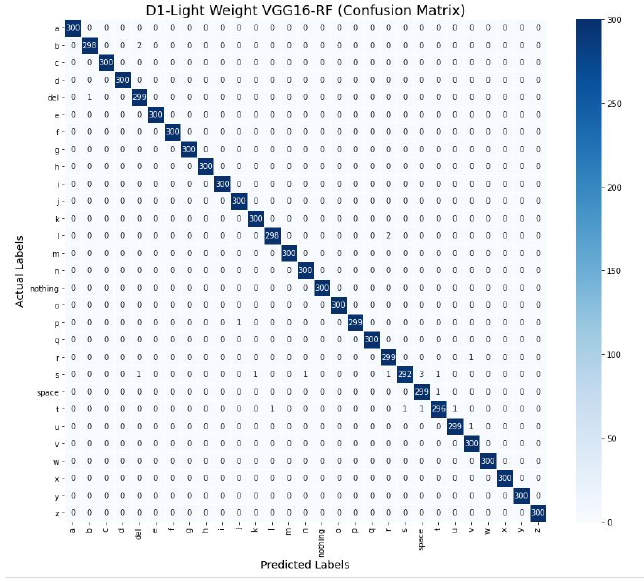
Figure 9. The confusion matrix of the lightweight VGG16-RF on the ASL dataset.